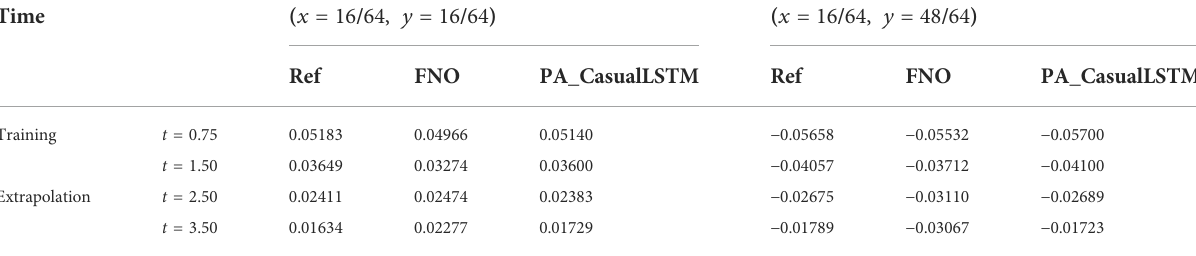
TABLE 1 Numerical result of the classical numerical method, FNO, and PA_CasualLSTM for Burger ’ s